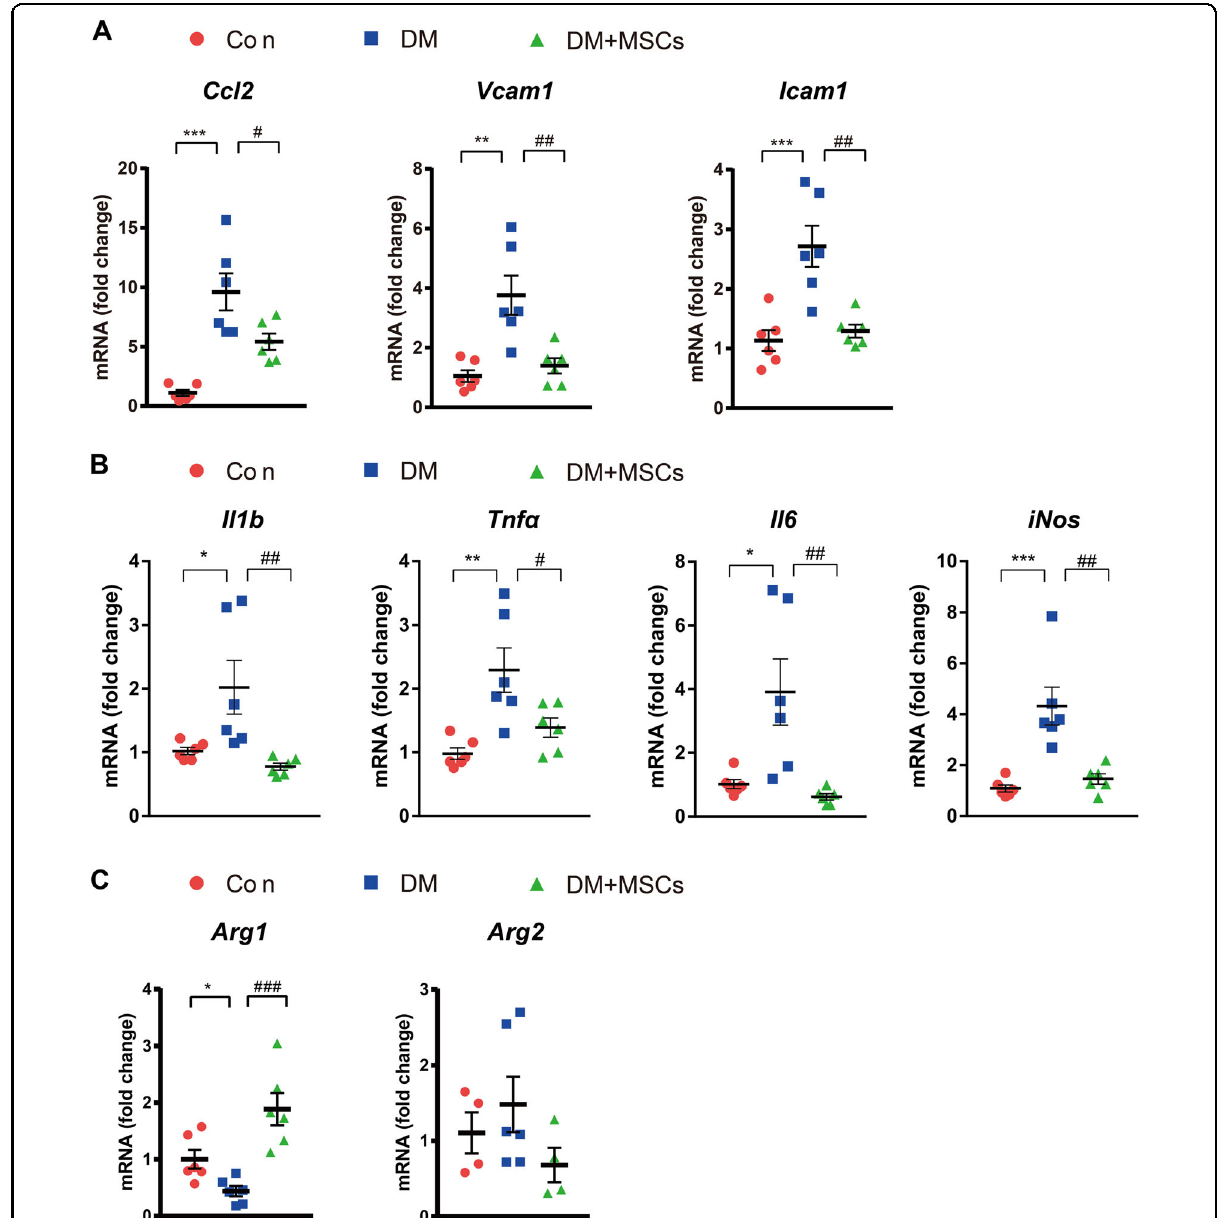
Fig. 2 MSC treatment decreased and increased the expression of M1 macrophages and Arg1 , respectively, in diabetic kidneys. a Real-time RT-PCR analysis of Ccl2, Vcam1 , and Icam1 expression in the kidneys. b MSC treatment decreased the expression level of M1 macrophage markers. c MSC treatment increased Arg1 expression, whereas it did not alter Arg2 expression. Con, non-diabetic CD1 mice; DM, diabetic CD1 mice; DM + MSCs, diabetic CD1 mice with MSC treatment. Data show the means ± SEMs of six mice. * P < 0.05, ** P < 0.01, and *** P < 0.001 versus Con; # P < 0.05, ## P < 0.01, and ### P < 0.001 versus